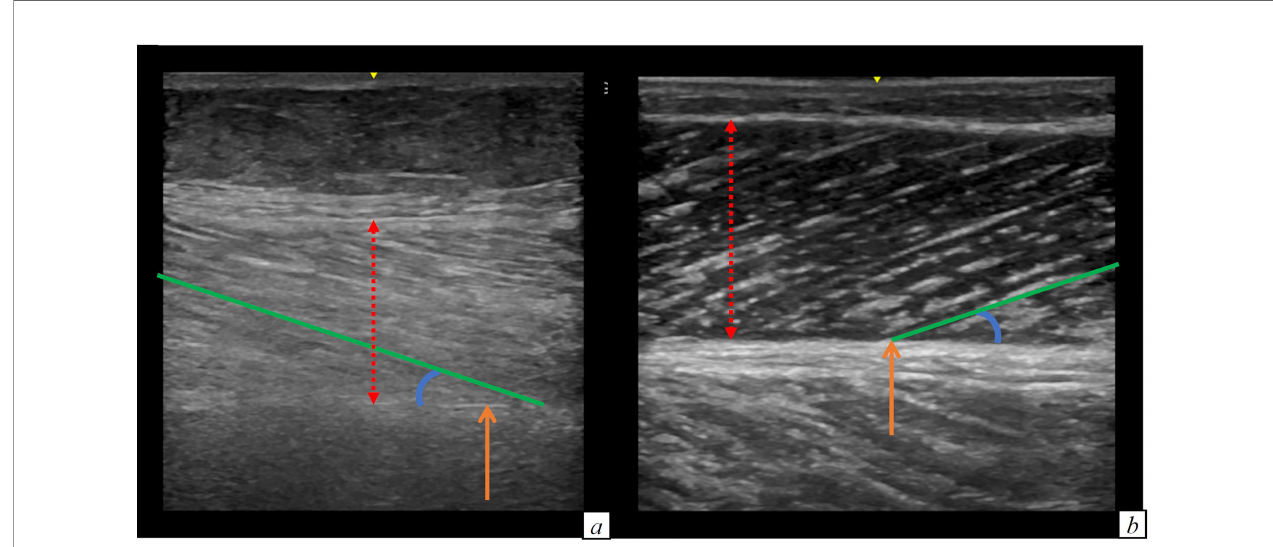
FIGURE 2 | Comparison of the limb ultrasound images of a patient with (A) and without probable sarcopenia (B) . (A) Muscle thickness: 1.54 cm, muscle stiffness 127 (B) Muscle thickness: 1.81 cm, muscle stiffness 46.8. RED DOTTED ARROW: muscle thickness; ORANGE ARROW: muscle deep aponeurosis; BLU CIRCLE LINE: pennation angle; GREEN line: muscle fascicle length.